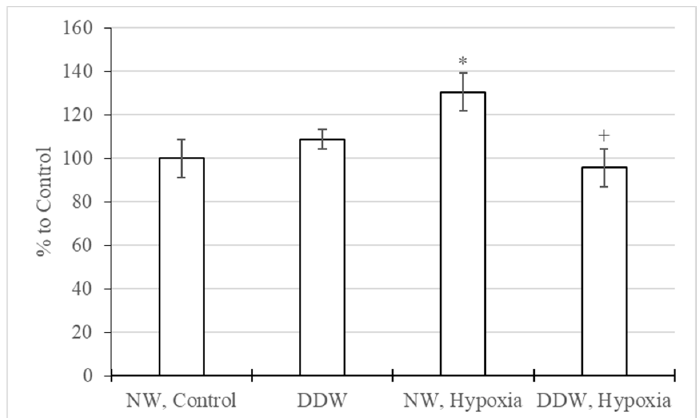
Figure 3. Catalase activity in the brain of rats consuming normal water (NW) and deuterium-depleted water (DDW) when exposed to hypoxia (M ± m). *— p < 0.05 compared with the “NW, Control” group, +— p < 0.05 compared with “NW, Hypoxia”.